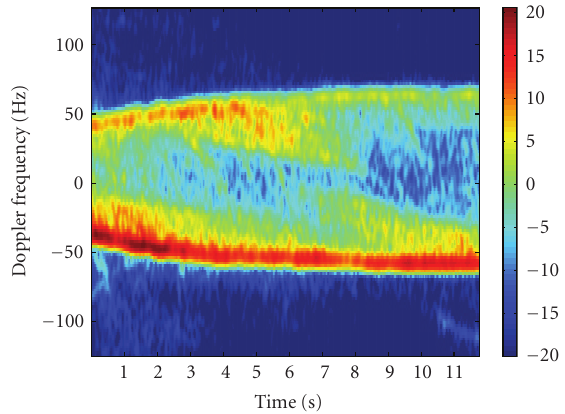
Figure 4: Doppler power (dB) spectrum measured at the top array on Slater